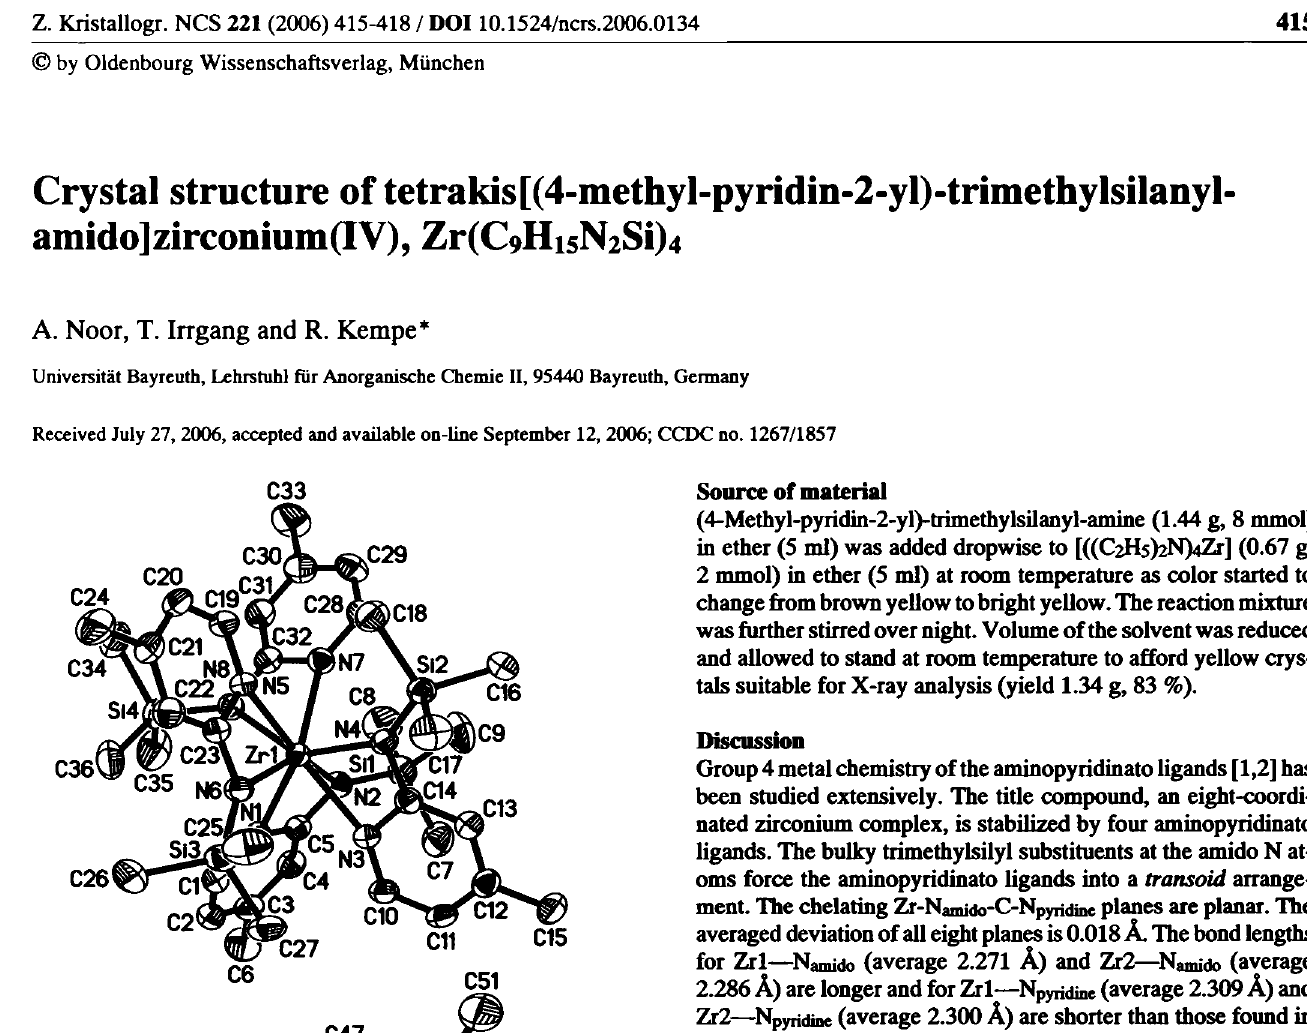
Table 1. Data collection and handling.